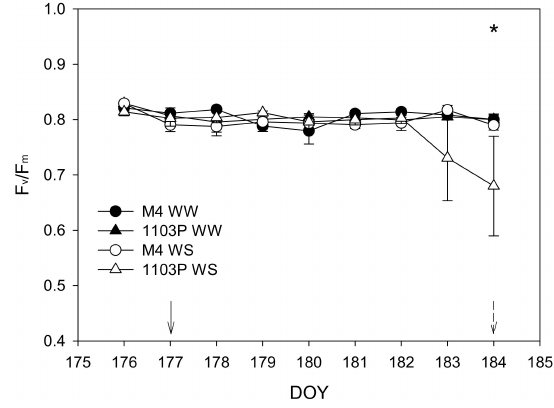
Figure 5. Trends for leaf chlorophylls fluorescence parameter (F v / F m) of Grechetto Gentile vines grafted to M4 and 1103P. M4-WW = well-watered vines / M4; 1103P-WW = well-watered vines / 1103P; M4-WS = water-stressed vines / M4; 1103P-WS = water-stressed vines / 1103 Paulsen; DOY = day of the year. Bars represent standard errors ( n = 5). Asterisk indicates dates within which significant di ff erences among treatments were found, according to the SNK test ( p < 0.05). Solid arrow indicates date of imposition of WS; dashed arrow indicates date of